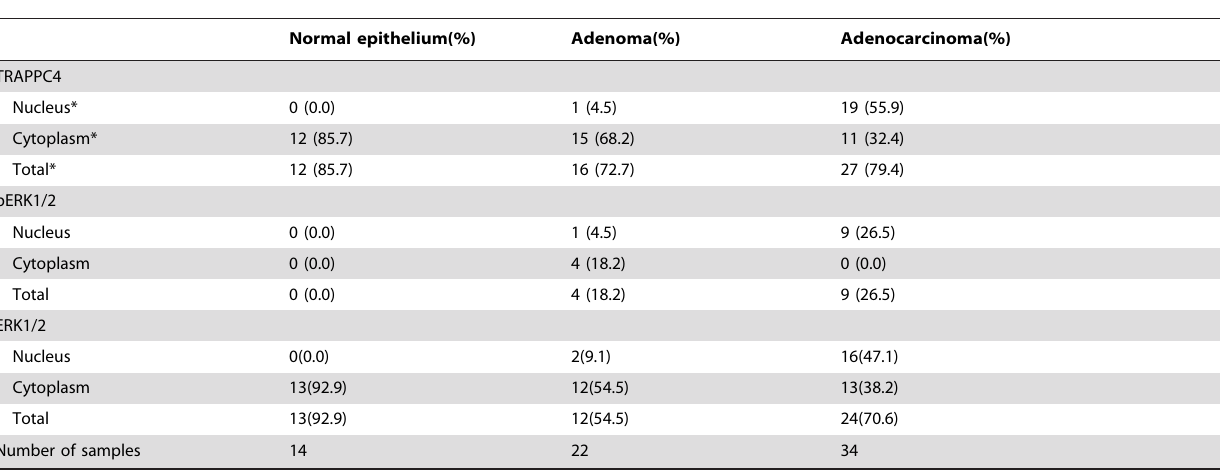
Table 1. Frequency of Expression of TRAPPC4, pERK1/2 and ERK1/2.